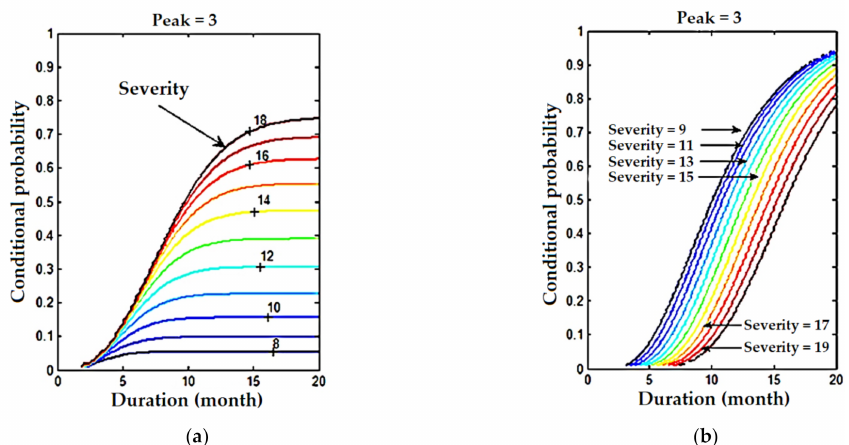
Figure 11. Conditional probability curves P DS | P ( a ) and P D | SP ( b ) for severity peak 3, based on one-month TSI for the Rasht Basin.